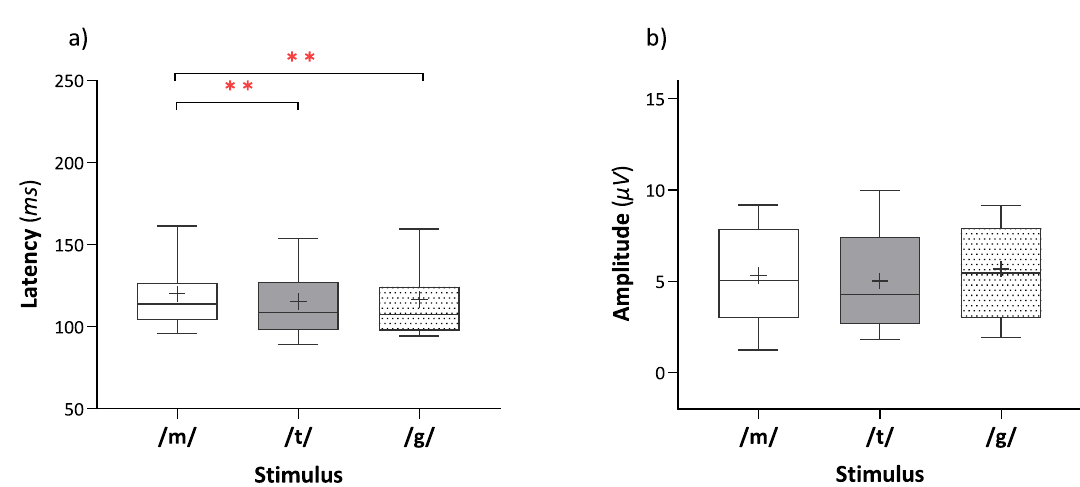
Figure 3. The main effect of stimulus (/m/, /g/, /t/) on P1 latency and amplitude presented by boxplots illustrating pairwise comparisons. The bottom and top of the box represent the 25th to 75th percentiles (respectively), the middle solid line represents the median, the + symbol represents the mean, and the whiskers extend between the 10th and 90th percentiles. ( a ) P1 latencies elicited by /m/ were significantly prolonged compared to the latencies elicited by /t/ ( p = 0.009) and by /g/ ( p = 0.001). P1 latency to /t/ and /g/ did not significantly differ ( p = 0.932). ( b ) The main effect of the stimulus on P1 amplitude was not significant ( p = 0.12). ** p <